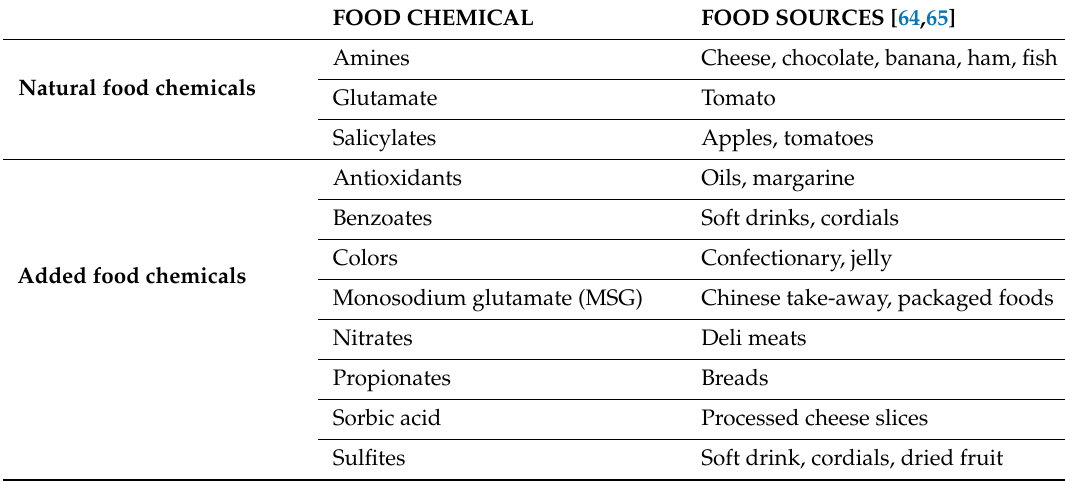
Table 3. Examples of foods containing natural and added food chemicals thought to induce gastrointestinal and extra-intestinal symptoms in gastrointestinal